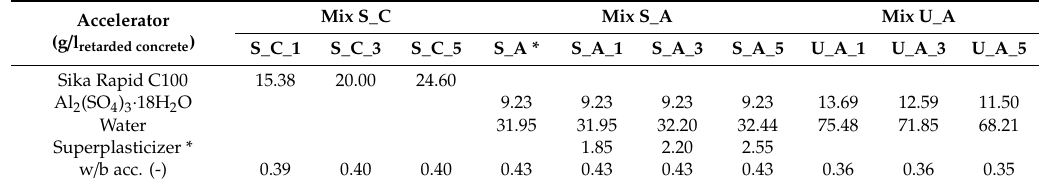
Table 2. Composition of the accelerated S_C, S_A and U_A mixes and the w / b ratio of these mixes after